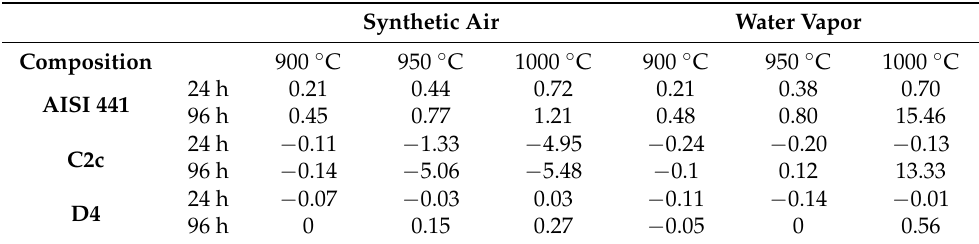
Table 3. Weight changes of test samples after oxidation tests in atmospheres of synthetic air or water vapor (mg/cm 2